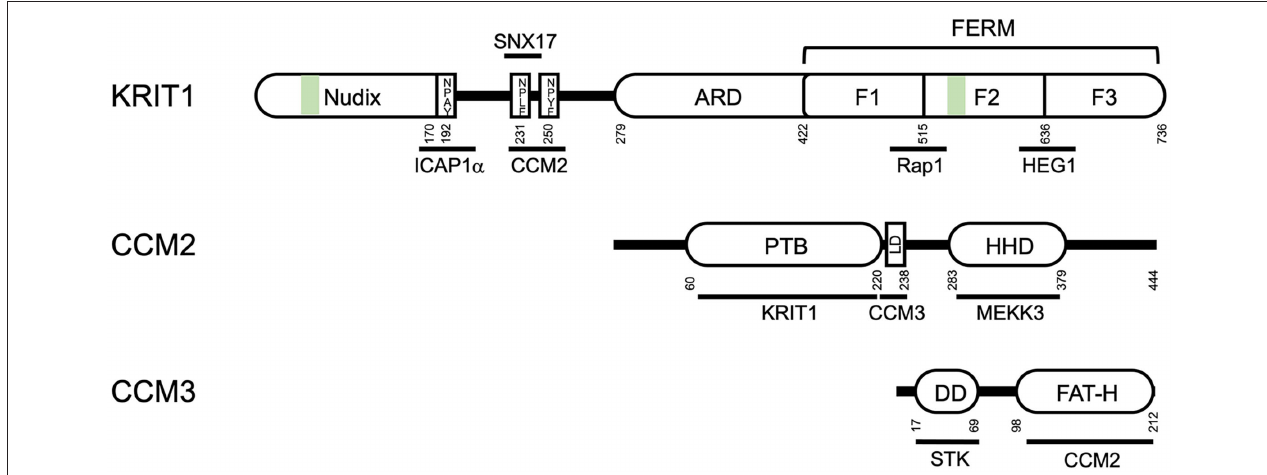
FIGURE 1 | Domain structure of the CCM proteins KRIT1, CCM2 and CCM3. ARD- ankyrin repeat domain; FERM- Band 4.1, ezrin, radixin, moesin domain; F1, F2, and F3, globular subdomains of the FERM domain; PTB, protein tyrosine binding domain; LD, leucine-rich aspartate domain; HHD, harmonin homology domain; DD, dimerization domain; FAT-H, focal adhesion targeting domain; STK, sterile kinase. Green bars indicate nuclear localization sequences/microtubule binding sites. Residue numbers (from human proteins) are noted below the domain